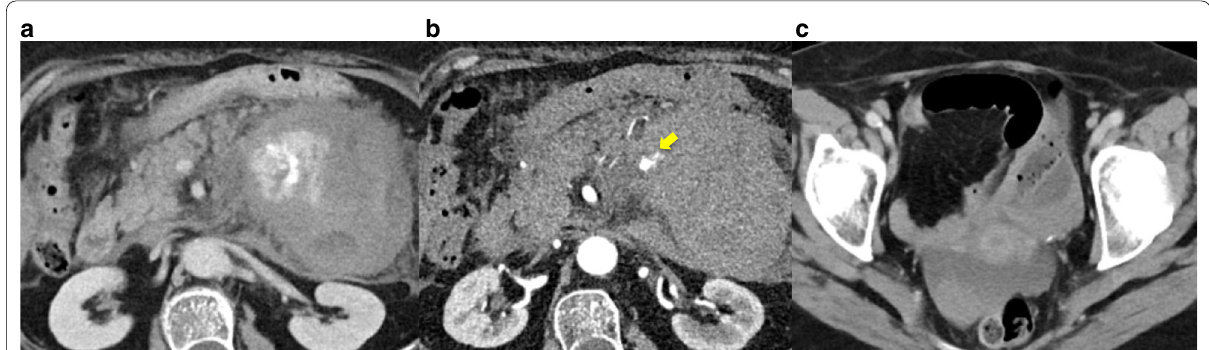
Fig. 1 Contrast enhanced computed tomography. a The retroperitoneal hematoma and extravasation of contrast spread to the ventral side of the